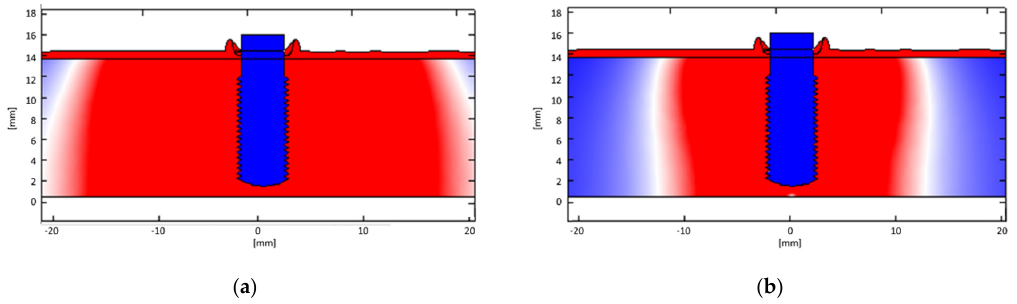
Figure 10. Regions above (red) and below (blue) ICNIRP limits for electric current density value (625 mA / m 2 ) for ( a ) a maximum intensity therapeutic signal and ( b ) a reduced one (25%). A dental arch adjacent to the implant is considered.